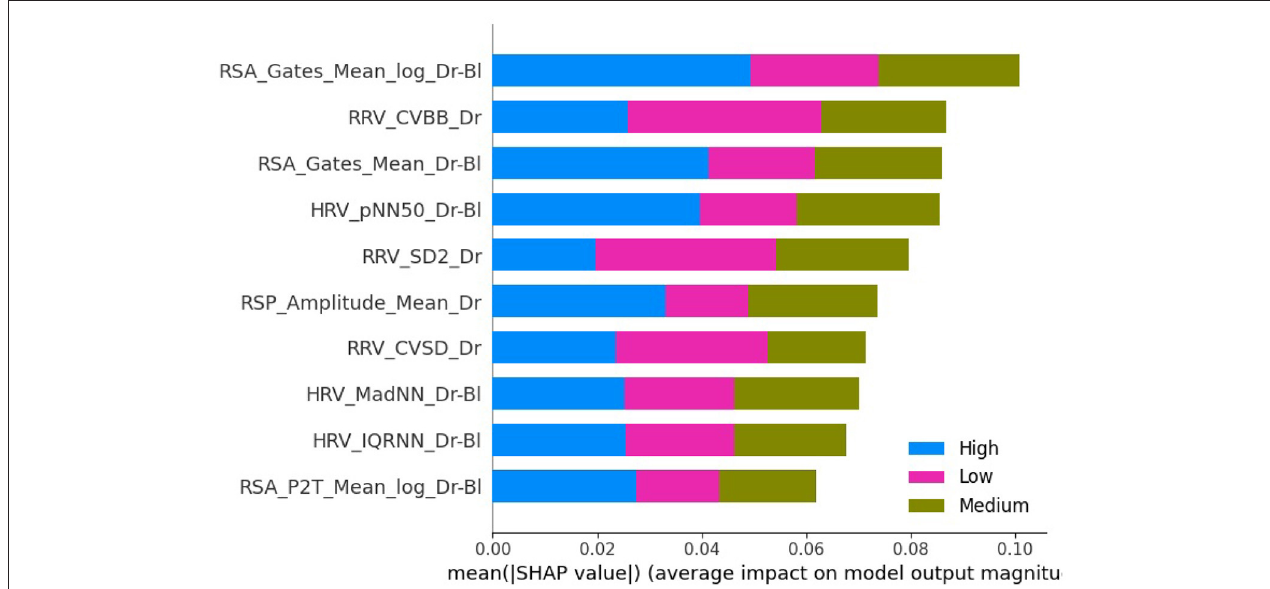
FIGURE 10 | Plot bar graph of the 10 most impacting features to predict drivers’ condition based on mean absolute SHAP values, arranged in descending order. The three signals (EDA + ECG + RESP) and a threshold for task performance of 100 were used. The meaning/description of each feature can be found in Table 2 . RRV, Respiratory rate variability; HRV, Heart Rate Variability; RSA, Respiratory Sinus